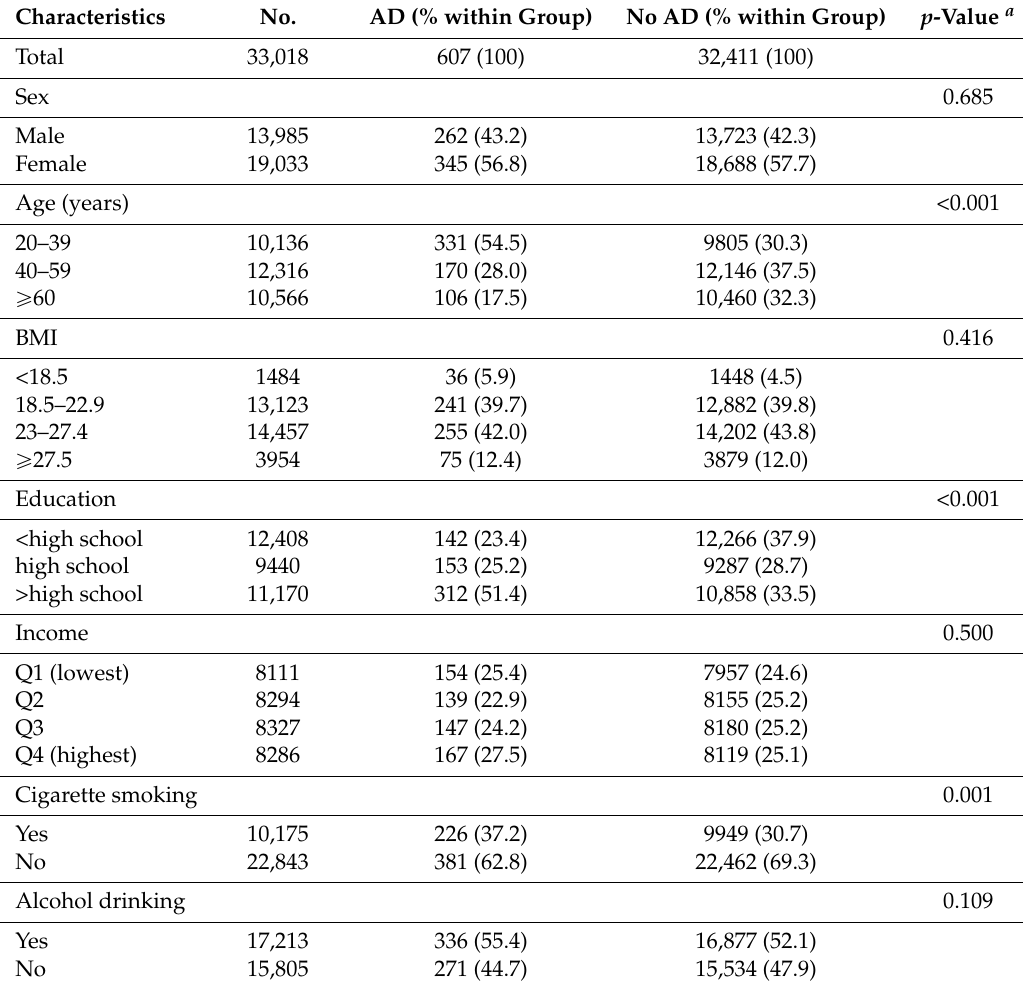
Table 1. Distribution of demographic characteristics by prevalence of atopic dermatitis among Korean adults ě 20 years of age ( n (%)).